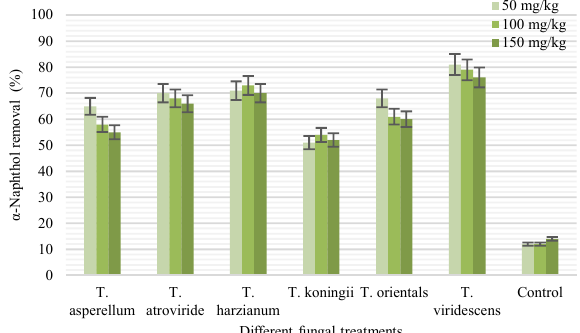
Different fungal Fig. 1. Removal of α-Naphthol (%; evaporation included) by studied fungal strains growing at α-naphthol concentrations of 50, 100, and 150 mg/kg (All fungal strains significantly decreased α-naphthol in media; P≤0.01)